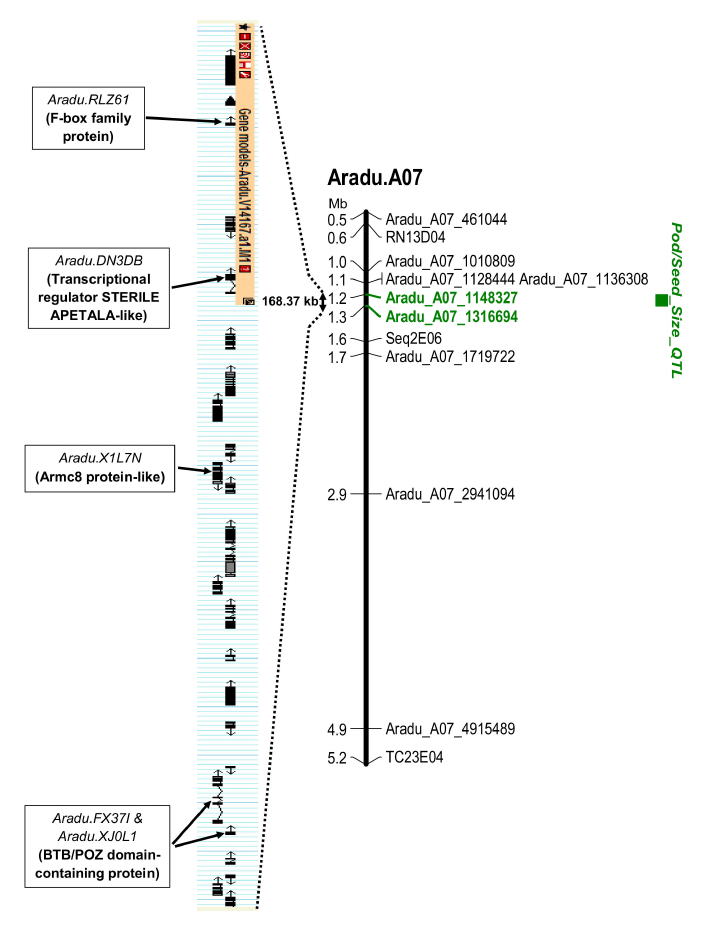
Figure 3. Position of the QTL responsible for reducing weight and size of pods and seeds on chromosome A07 and distribution of the candidate genes in the target region. The markers delimiting the QTL for pod / seed weight and size ( Pod / Seed Size_QTL ) reduction region are designated in